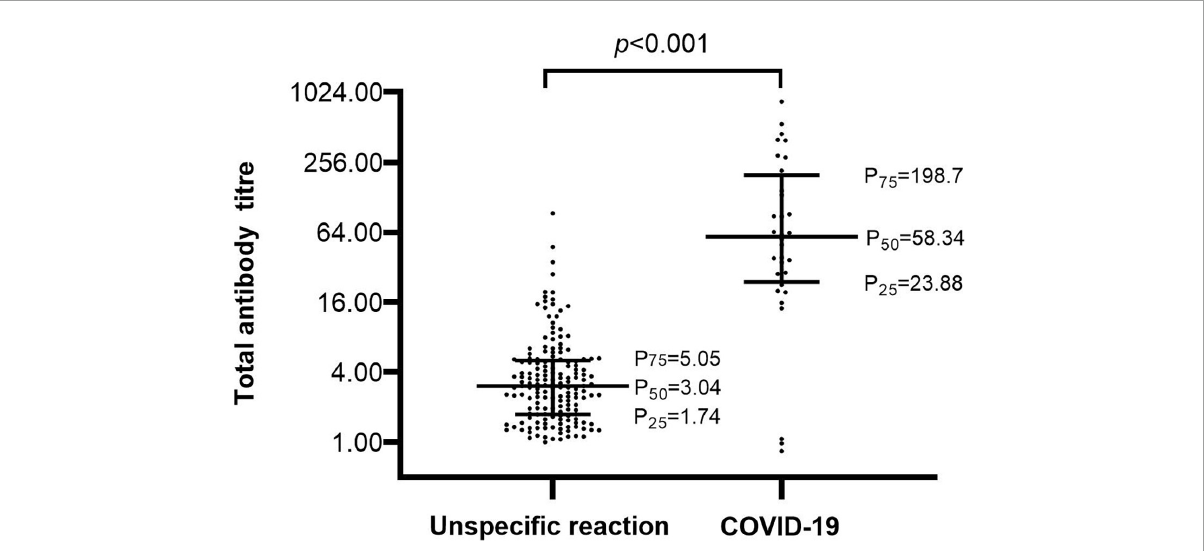
FIGURE2 Comparison of total antibody titers between the unspecific reactivity and COVID-19. Bars represent the arithmetic median with the interquartile range.